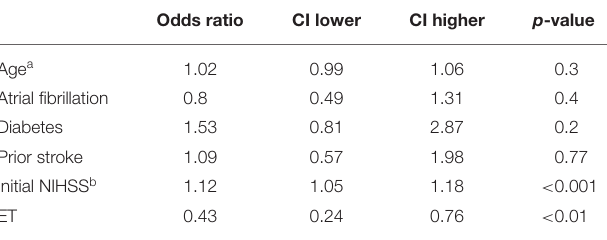
TABLE 4 | Multivariable odds ratios and 95% confidence intervals of poor outcome in dependent patients. Odds ratio CI lower CI higher p